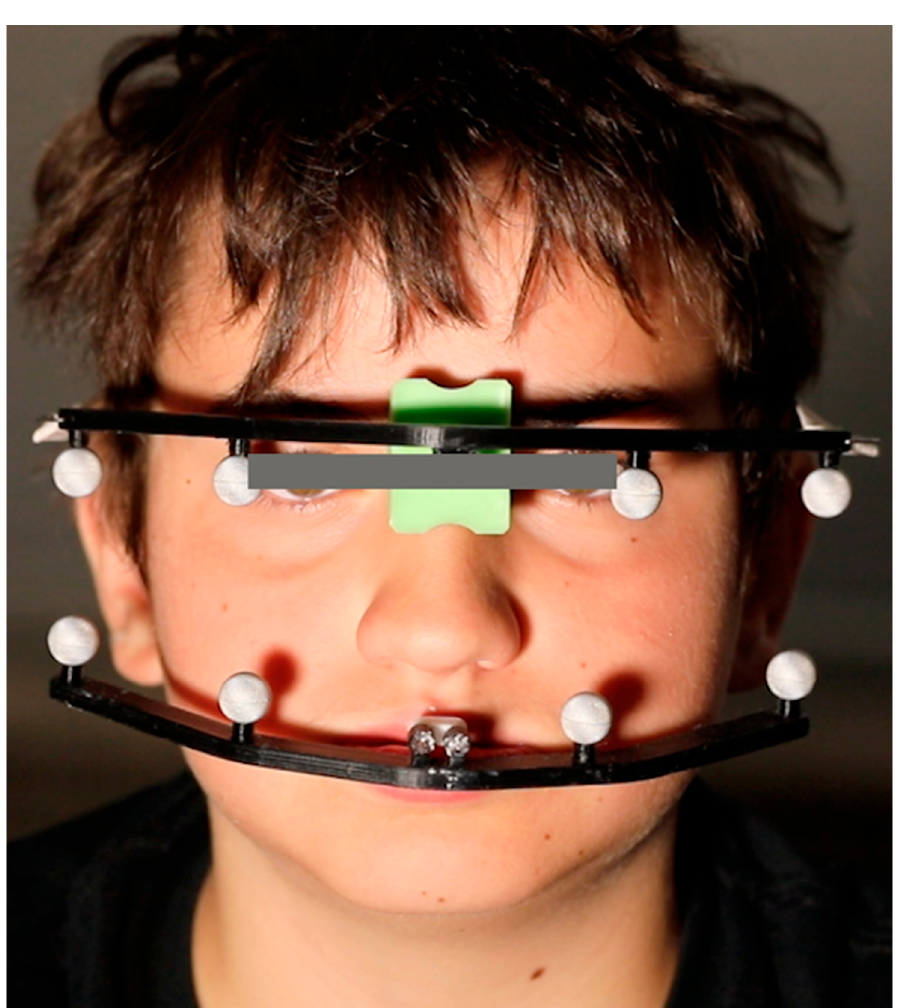
Figure 2. The upper and lower marker supports placed on the patient’s head: the cranial support with reflective markers fits the nasion point with a soft body anteriorly and an elastic band posteriorly. The lower support fits the lower dental arch with a resin attachment and it is not interfering with occlusion.